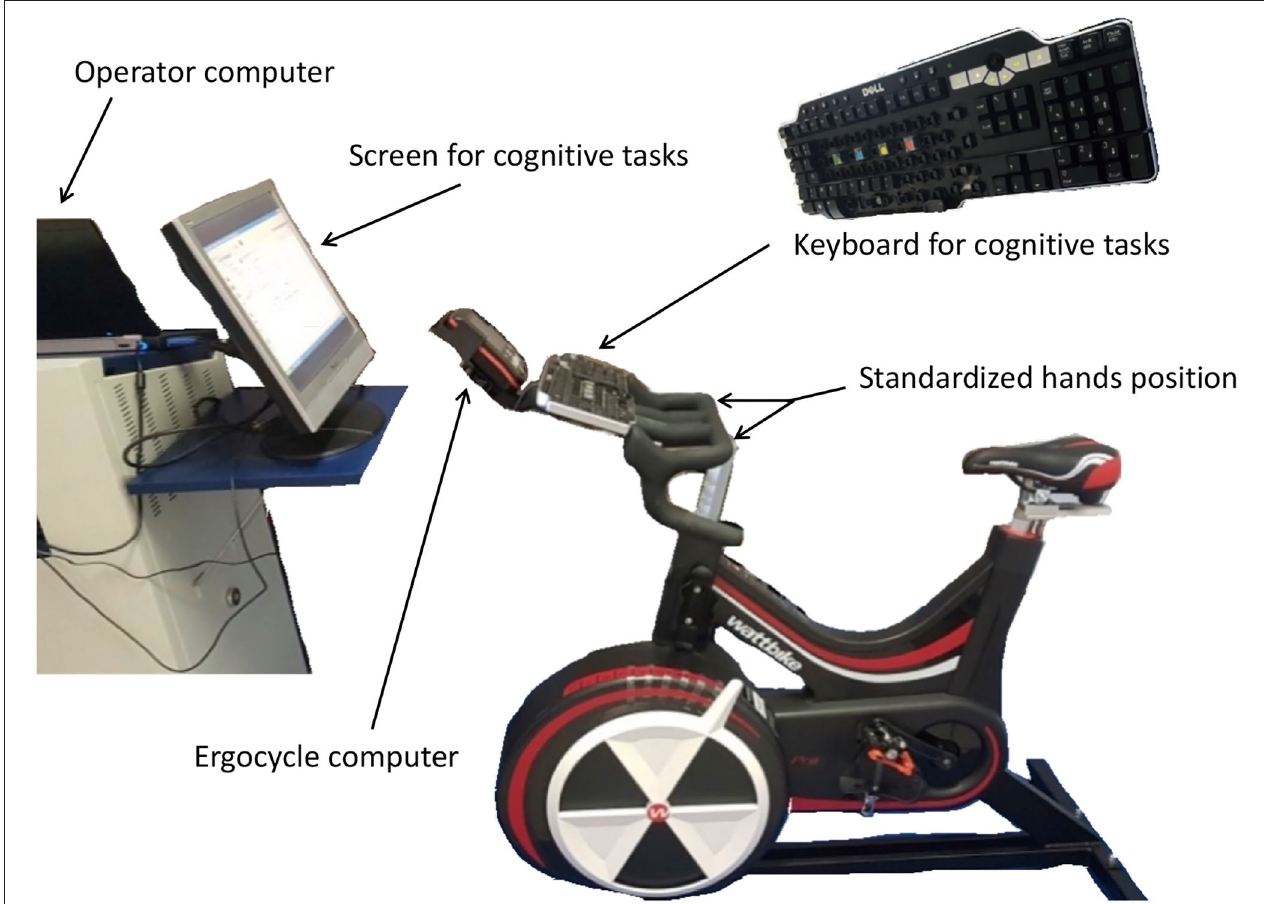
FIGURE 2 | Experimental setup. The experimental procedure was conducted on a Wattbike ergocycle. Cognitive tests were performed with a keyboard positioned on the handlebar and a computer screen facing the ergocycle. During cognitive tests, hands were first positioned on the handlebar. Volunteers then had to press the keyboard as quickly as possible with the index finger of the right hand. For the Stroop test, four colored keys were identified in the middle of the keyboard. For the reaction time, volunteers had to press the red key. For the backward digit span task, volunteers had to write the digits on the numerical keypad.